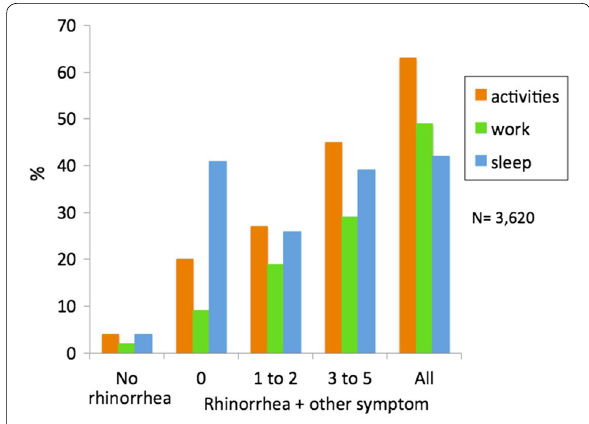
Fig. 6 Impact of allergic rhinitis depending on the number of symptoms (from Bousquet et al. [33])